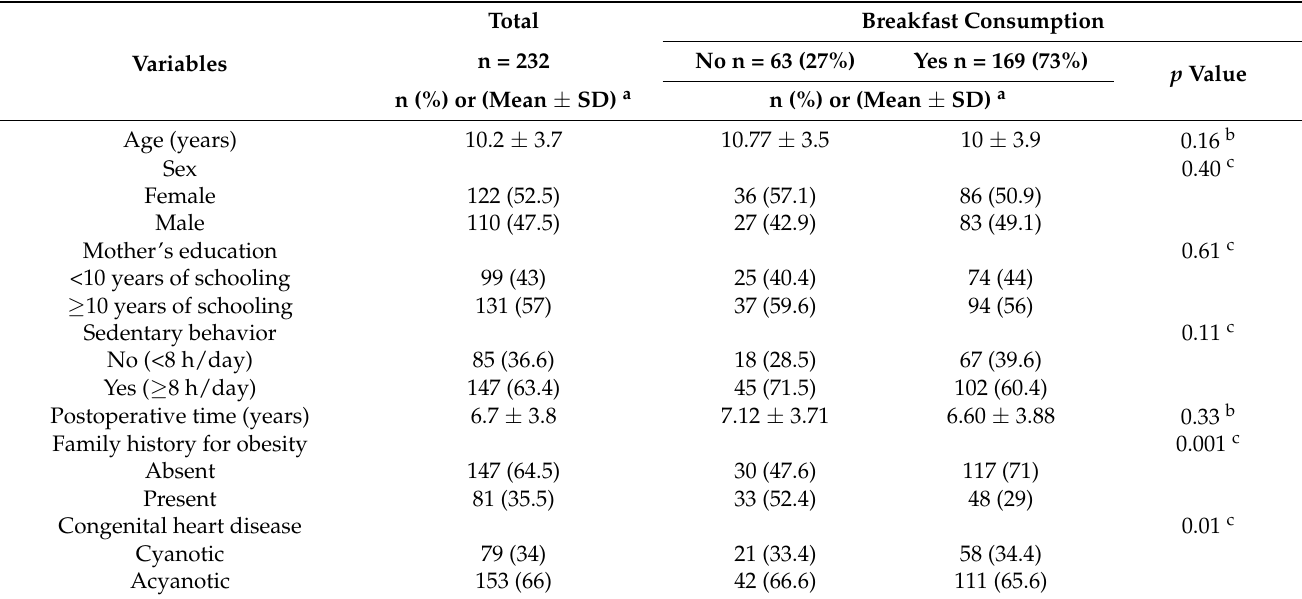
Table 2. Sociodemographic, clinical and lifestyle data of a cross-sectional study with 232 children and adolescents with CHD according to breakfast consumption. Brazil